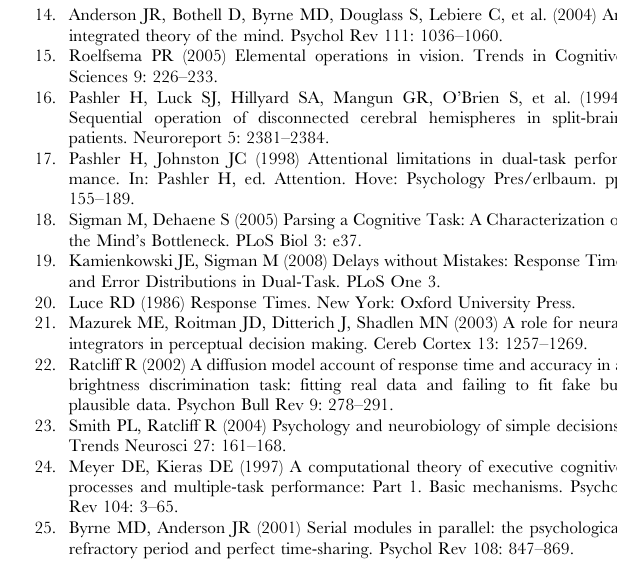
Figure S6 Combinatorial router. A) In the model, each neuron in the router coded exclusively for particular combinations of stimulus and response. This would lead to scaling issues when the number of possible mappings increases. Here we sketch a different coding schema for the router, one that works on the basis of combinatorial codes. A small portion of the network is simulated, containing only parts of the router and motor networks. See the main text and the model of Lo & Wang (Lo & Wang, 2006) for details of the circuit, specially the disynaptic inhibitory circuit by which the router both excites the different motor neurons and inhibit the tonic inhibition of those same motor units, implement- ing a threshold detection mechanism for the activity in the router. Two populations of excitatory neurons need to code for three different stimuli, each one mapped to a different response. Thus, the simultaneous activation of both router populations lead to a third response different from the one generated by each population alone, by tuning the synaptic efficacies such that the response in the center of panel A (light brown) receives a larger excitatory input than the other responses only when both router inputs are active. (BCD) Population firing rate of both router populations - during a simulation of the model - for the three possible stimuli. X-axis indicates the time relative to stimulus